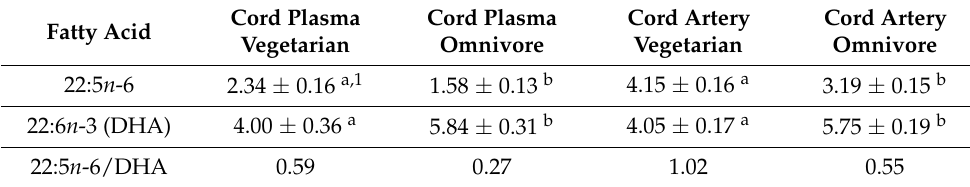
Table 4. Cord plasma and cord artery DHA and 22:5n-6 levels from vegans and omnivores (% of total fatty